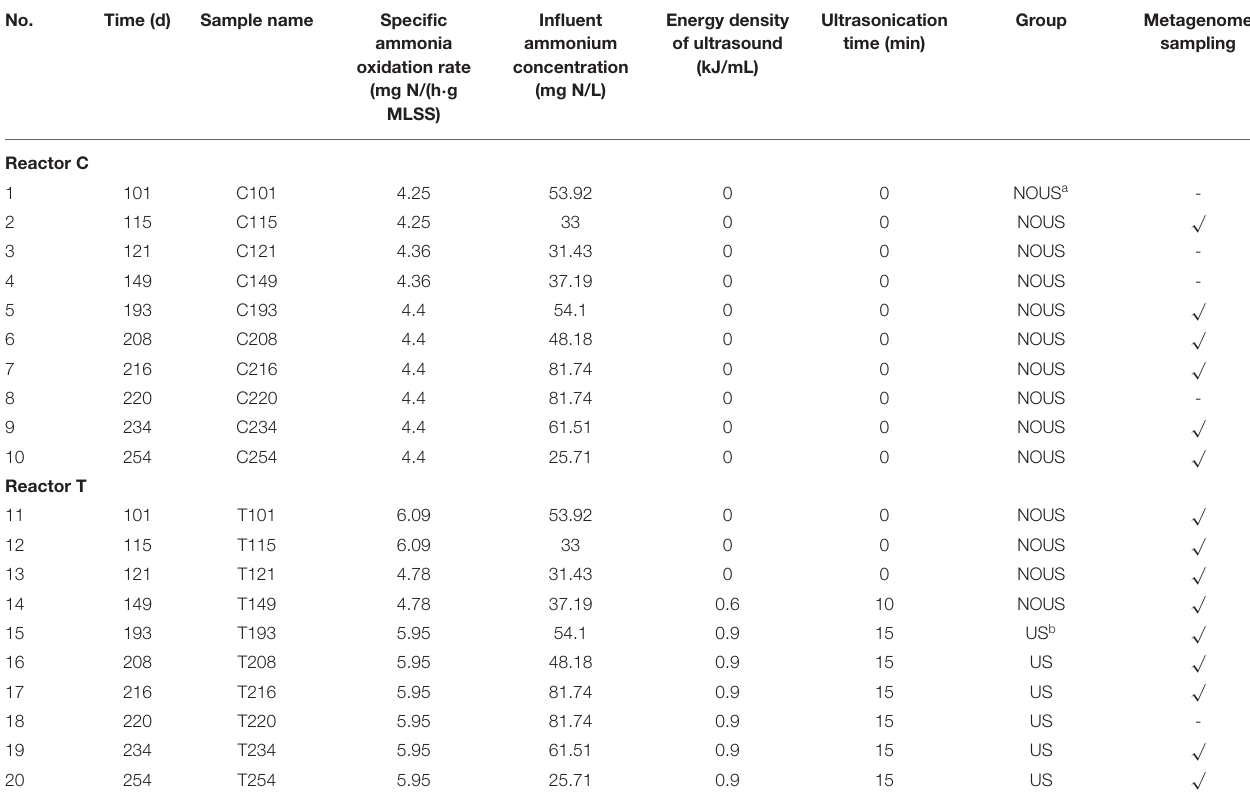
TABLE 1 | Reactor performance, ultrasonic treatment conditions, and sampling.